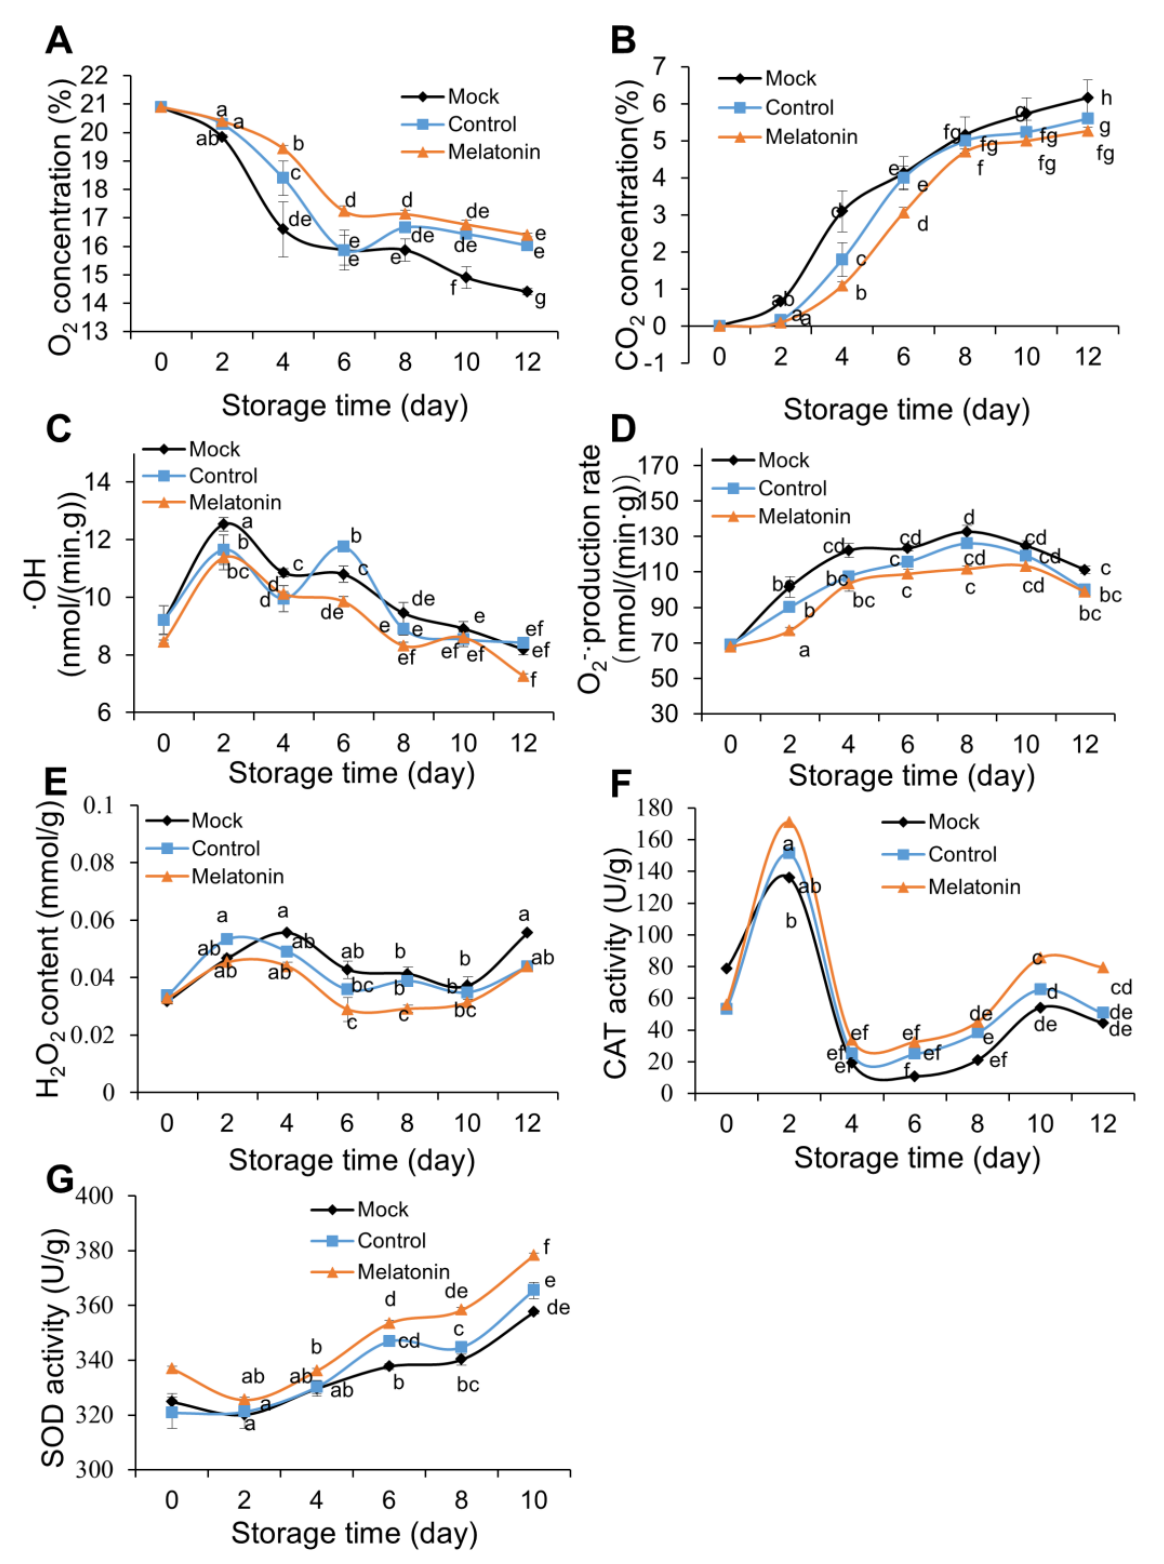
Figure 3. Effect of melatonin on gas headspace change ( A , B ), ROS ( C – E ) and SOD activity ( F ), and CAT activity ( G ) of fresh-cut lotus roots (‘E Lian 5’). Fresh-cut lotus root was treated with tap water (Mock), ethanol (Control), or 40 mmol/L melatonin solution (melatonin). Error bars represent SEs from three biological replicates. Different letters represent significant differences at p < 0.05 level.